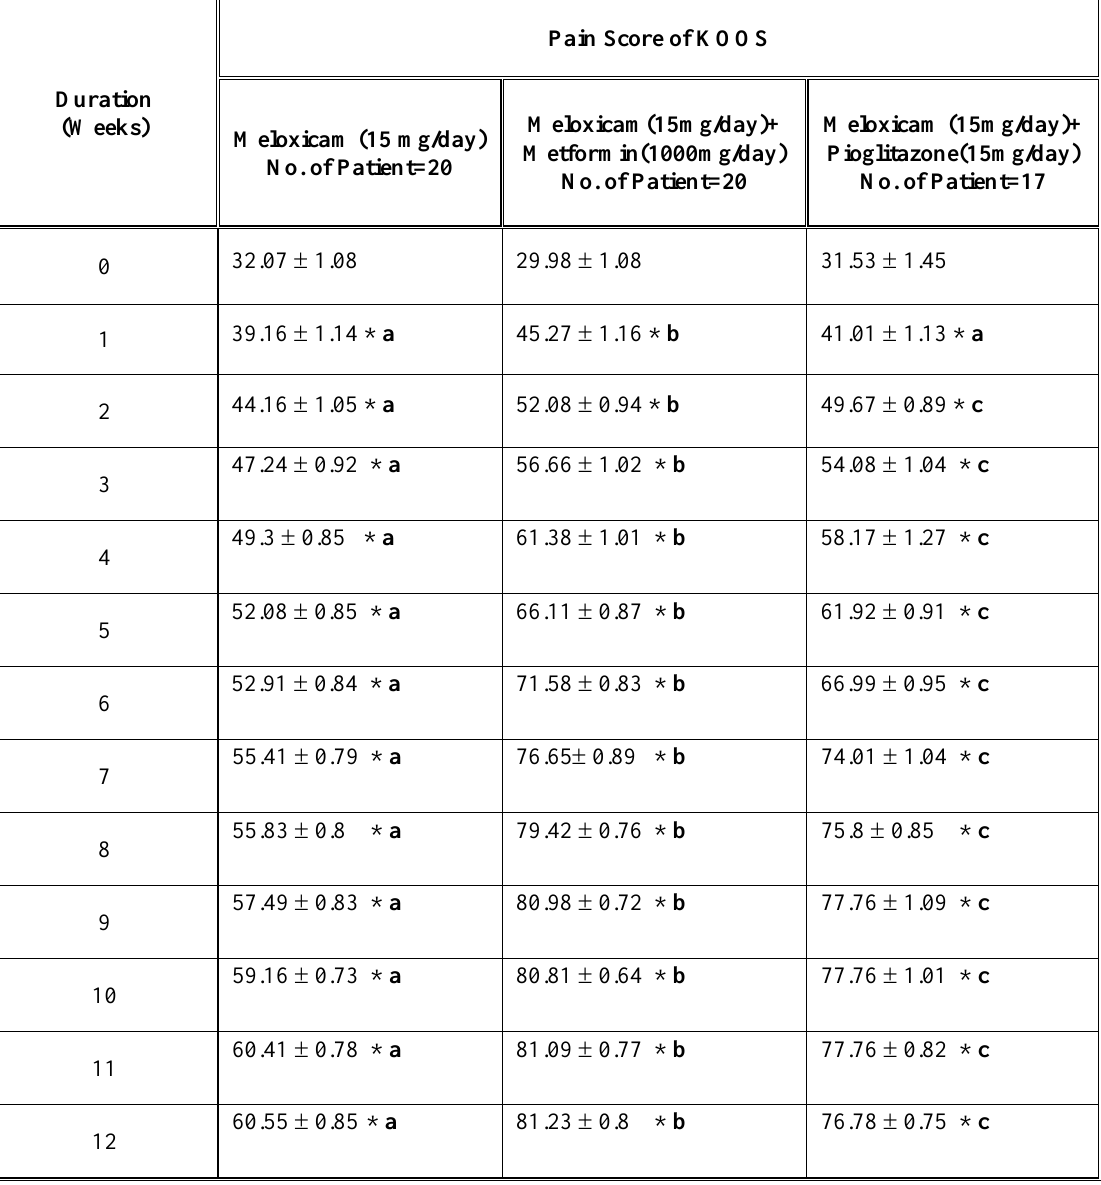
Table(1): Effects of treatment with meloxicam alone, combination of meloxicam + metformin, and meloxicam + pioglitazone on pain score in osteoarthritic